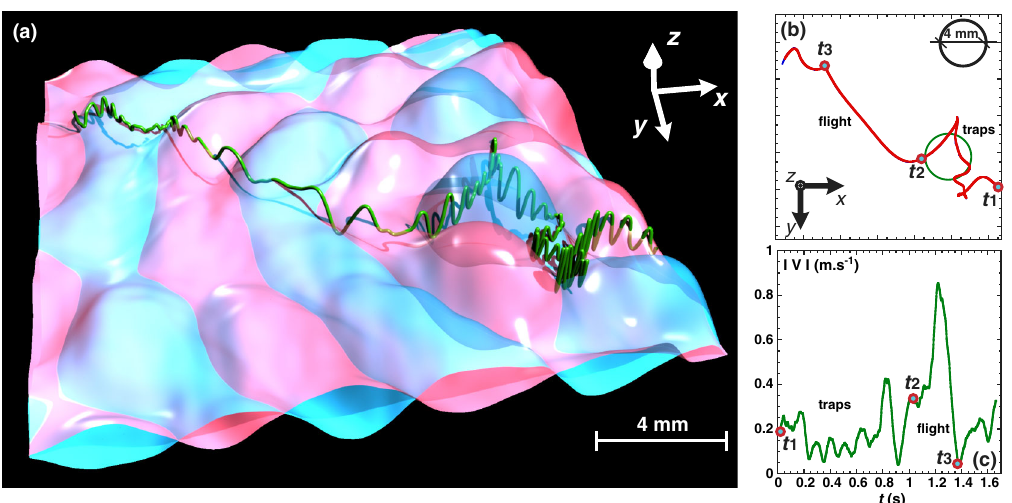
FIG. 1. (a) Perspective view of a three-dimensional particle trajectory followed for 1.6 s at a frame rate of 587 frames per second in a ¼ 0 . 6 g ) and f ¼ 60 Hz. Pink and blue wave fields correspond to two consecutive wave field parametrically excited at a ¼ 1 . 6 g ( a 0 th phase extrema of the waves that are separated in time by one period of the shaker oscillation (Faraday waves are parametrically excited waves). (b) Horizontal 2D projection of the same trajectory. A green circle of radius λ = 4 ≈ 2 mm is indicated. (c) Absolute value of the horizontal particle velocity averaged over one Faraday